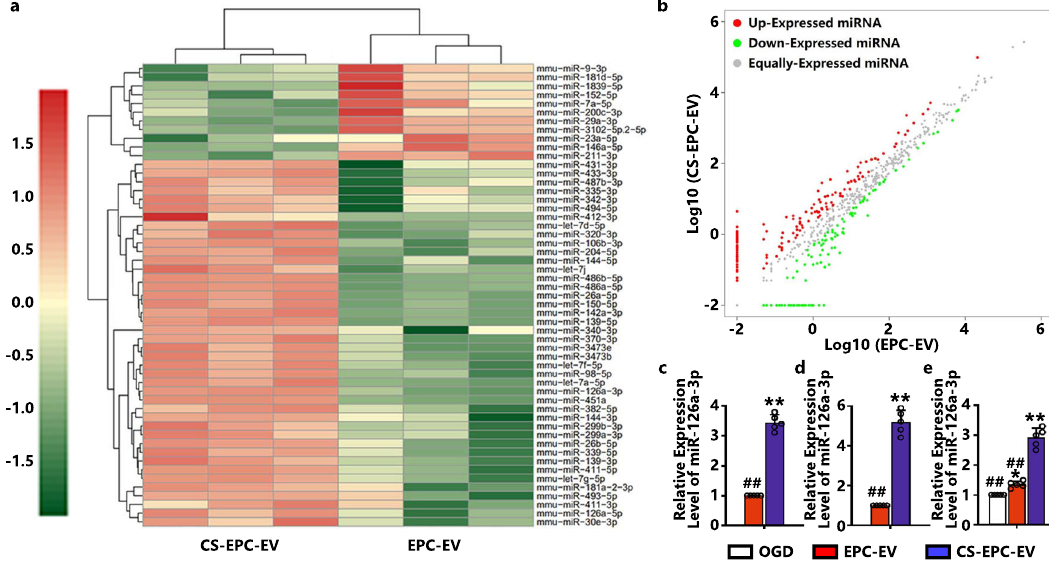
Fig. 7 | Silicate ions from CS bioceramics promote the expression of angiogenesis-related factors and miRNAs in EPC-derived EVs. a Heatmap of miRNA differential expression analysis between samples. Red represents upregu- lated genes, green represents downregulated genes, and color depth represents log10 (COUNT+1) values. b Scatter plot of miRNA differential expression analysis between samples. Red dots indicate signi fi cantly upregulated miRNAs, and green dotsindicatesigni fi cantlydownregulatedmiRNAs. c TheexpressionofmiR-126a-3p intheEVswasmeasuredbyqRT ‒ PCR.** p <0.01vs.EPC-EVs,## p